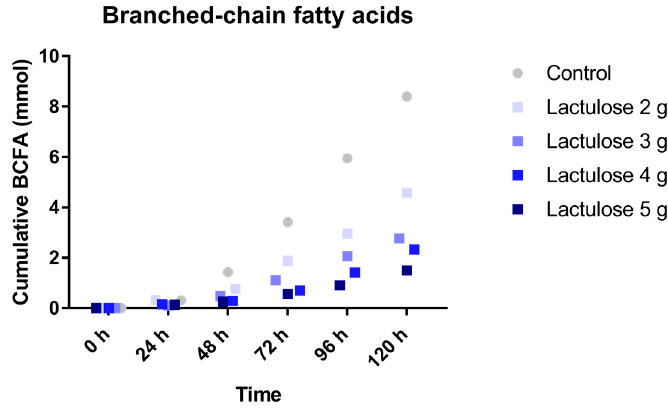
Figure 3. Cumulative branched-chain fatty acids (BCFA) (iso-butyrate and iso-valerate) production over time during the 120 h test period in TIM-2 runs (mean of n = 2 (Lactulose dosages) or n = 4 (control)). All data points shown at the proximity of the individual time points indicated at the X -axis belong to these specific time points.